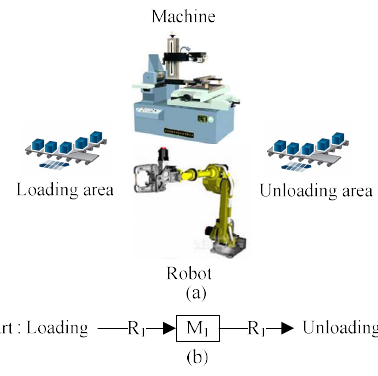
Figure 1. ( a ) Automated manufacturing system (AMS) example and ( b ) operation sequence.